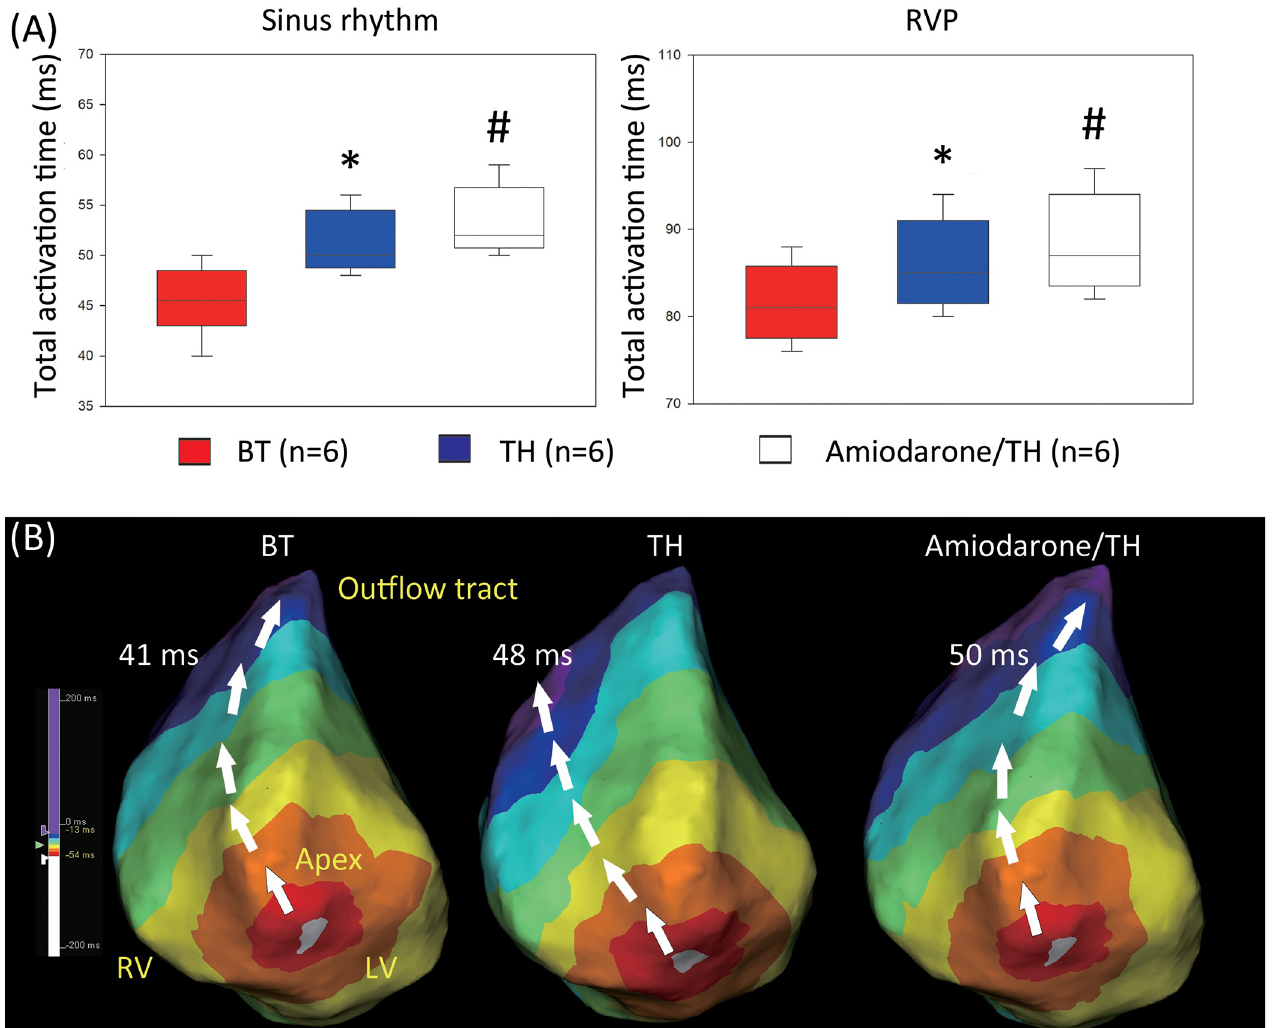
Fig 2. Sequential changes in the TAT after TH and amiodarone treatment. (A) Sequential changes in the TAT after the induction of TH and amiodarone infusion (amiodarone/TH) either during SR (left panel) or RVP (right panel). These data were derived from the six pigs from protocol I. (B) Representative isochronal map of pig 1 during SR (left panel: BT, middle panel: after TH, and right panel: after amiodarone infusion). The Panel B showed a left anterior- oblique (LAO) view to the heart. The upper part indicated anterior aspect of the heart and the lower part indicated the posterior aspect of the heart. From a LAO view, the LV was in the right side and RV in the left side. The landmark was highlighted in yellow color. The white color on the map indicated the earliest activation site and followed by red, orange, yellow, green, light blue, blue, and purple color. * P < 0.05, BT vs. TH; # P < 0.05, TH vs. Amiodarone/TH, both by the paired t-test. The data are presented as means ± standard deviations. BT, baseline temperature; LV, left ventricle; RV, right ventricle; RVP, right ventricular pacing; SR, sinus rhythm; TAT, total activation time; TH, therapeutic hypothermia.